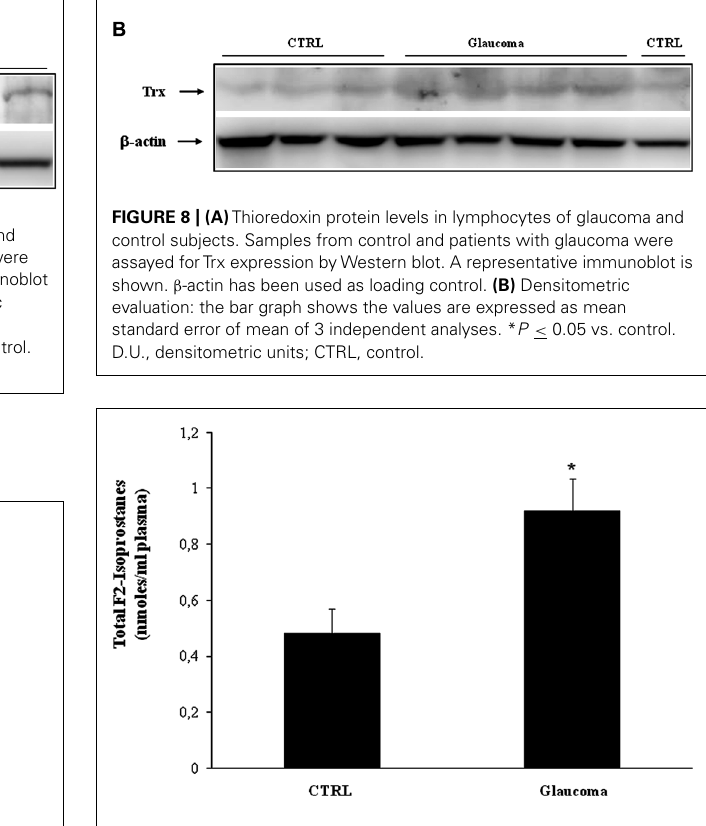
also considered in the pathophysiology of open-angle glaucoma, although the question still remains elusive (Quigley and Broman, 2006). Oxidative stress is considered an important risk factor for the development of primary angle-closure glaucoma and increased levels of oxidative stress products have been documented in pri- mary angle-closure glaucoma (Shieds et al., 1996; Izzotti et al., 2006; Butterfield et al., 2011). Visual loss which often starts in the periphery and advances involving central vision, has devas- tating consequences to patient’s quality of life (Gupta et al., 2006; Quigley and Broman,